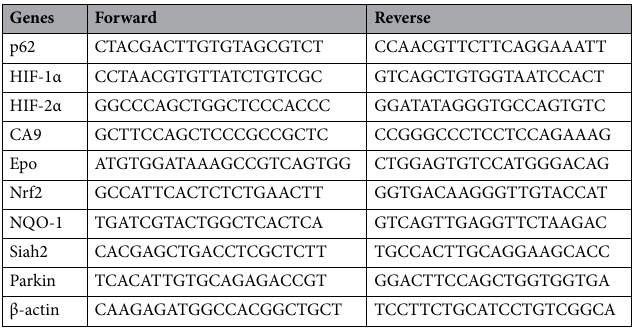
Table 2. List of primers used for a gene expression analysis by